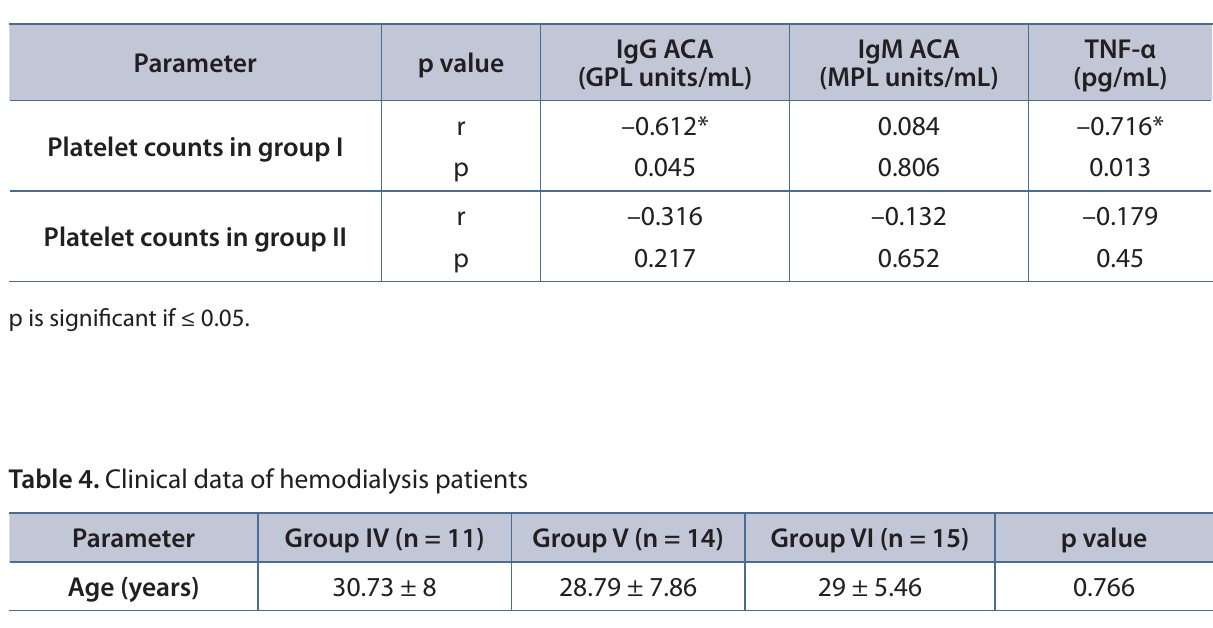
Table 3. Correlation between platelet counts, TNF-α and ACA values among thrombocytopenic patients